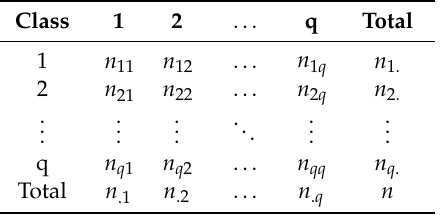
Table 2. Example of error matrix of sample counts, n ij [38].